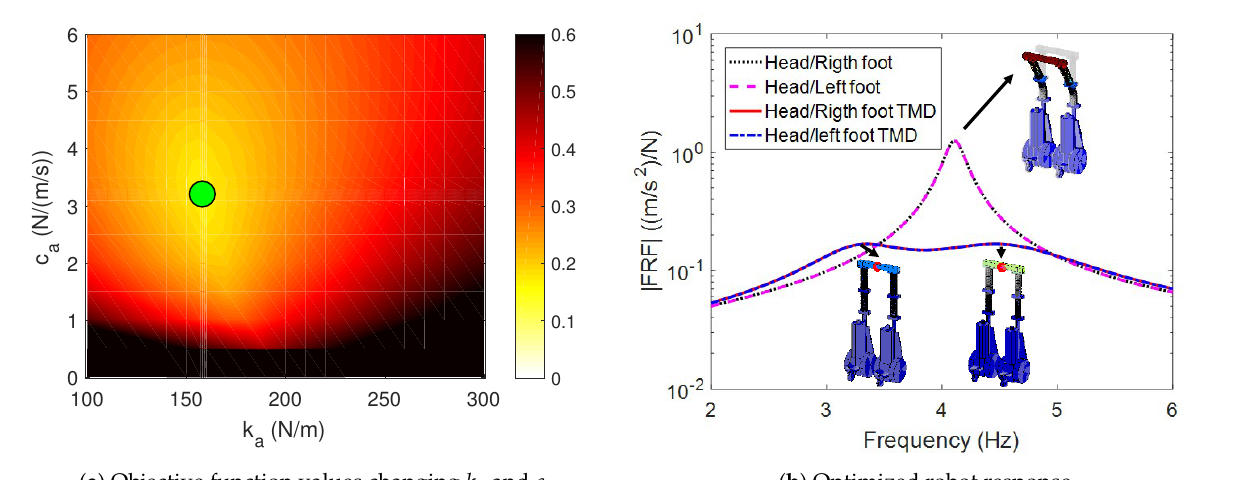
Figure 9. Optimisation of the acceleration at the supporting head beam during locomotion.